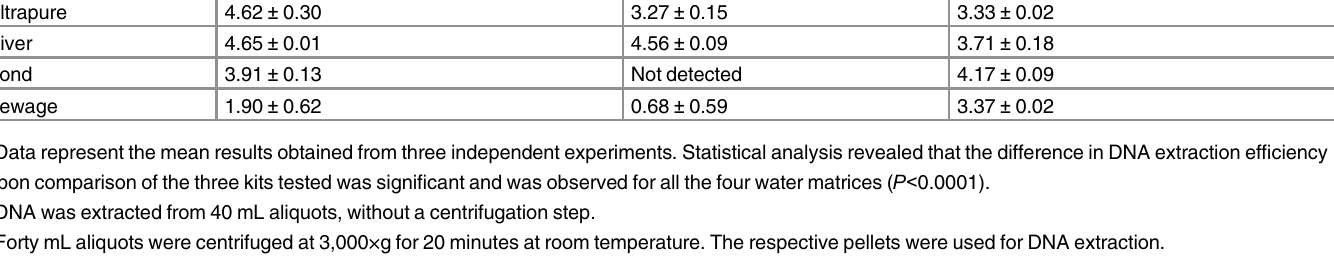
Table 1. Comparison of the efficiency of DNA extraction for three commercial kits from four water types spiked at 1 × 10 5 Leptospira /mL.